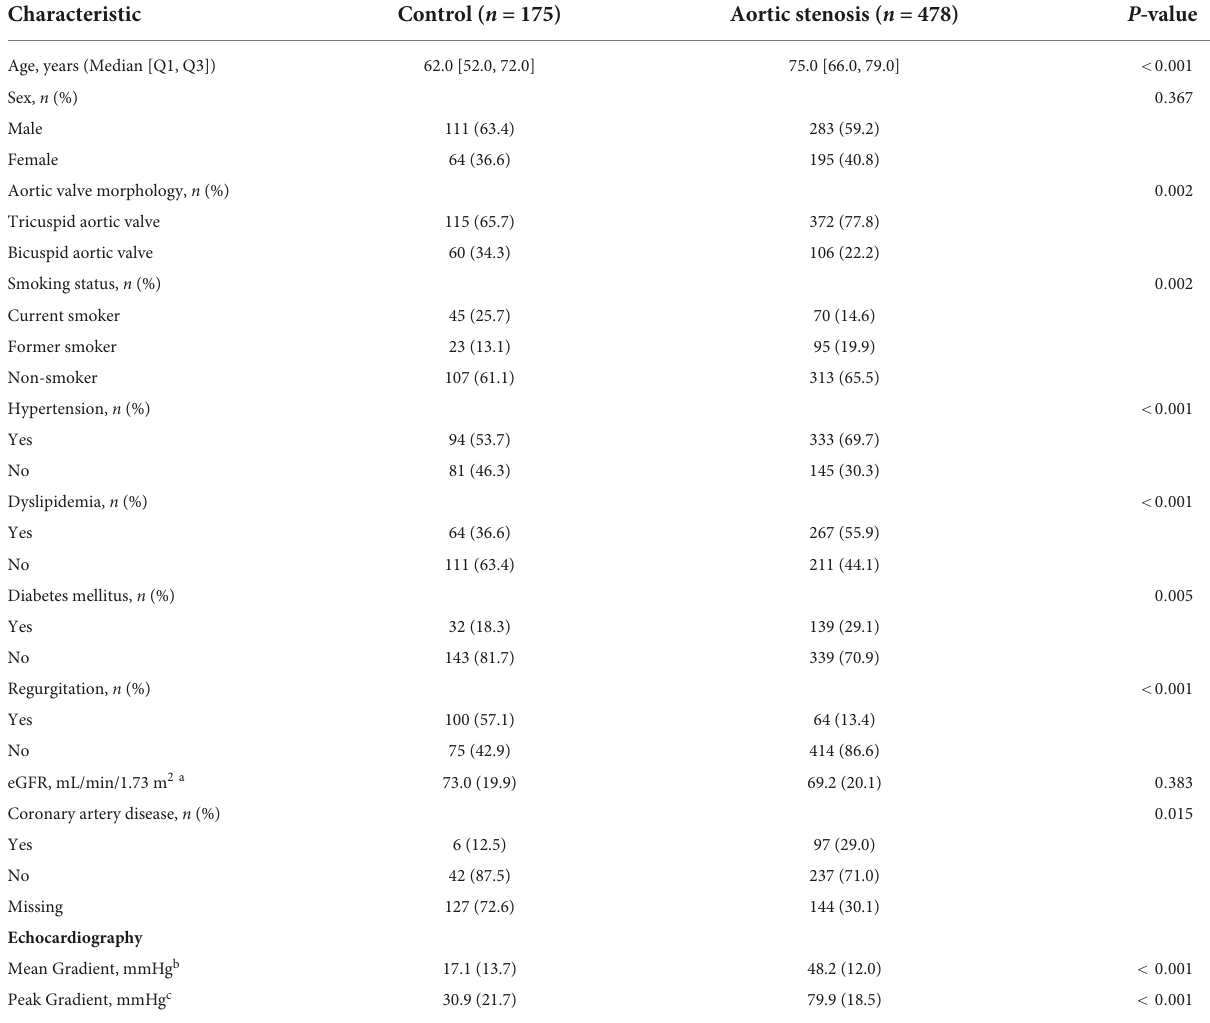
TABLE 1 Characteristics of patients included in the study, according to medical